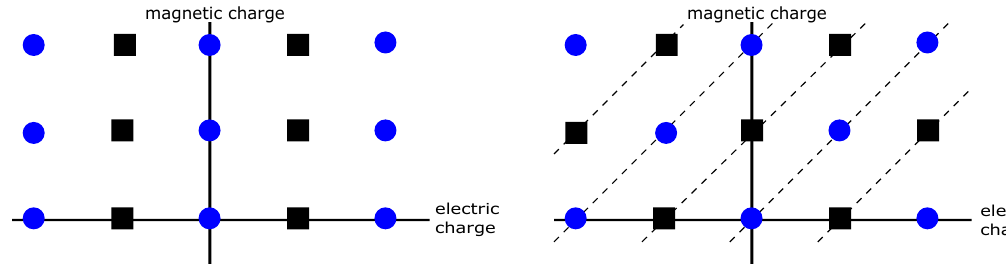
Figure 1 . Charge lattices at θ = 0 (left) and θ = π (right) for N = 2 . The blue blobs show the charges of dynamical excitations, while the black squares show those of test particles satisfying the Dirac quantization condition. The electric charges of dynamical excitations are quantized to the multiples of N , N Z , and the other charges can be present only as test